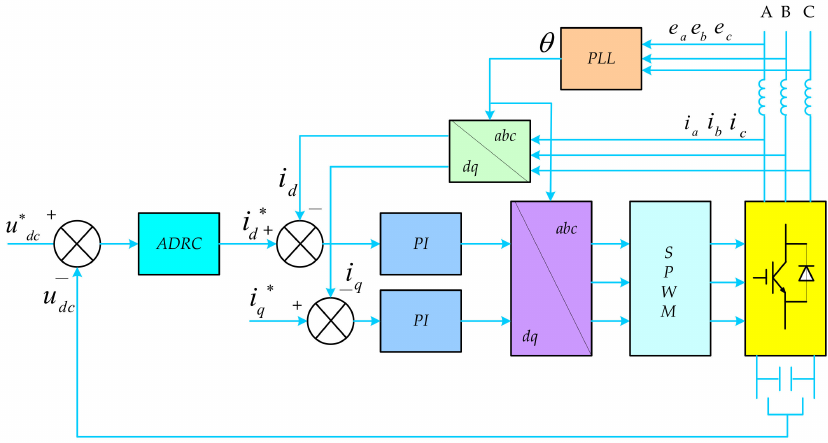
Figure 3. Control structure diagram of photovoltaic grid-connected